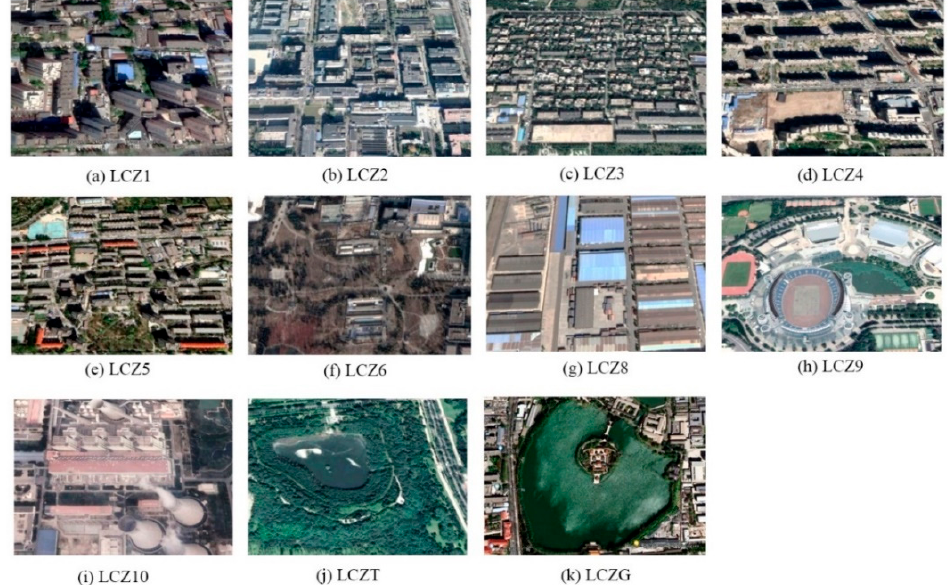
Figure 4. Samples of the LCZ from Google Earth: ( a ) LCZ1: compact high-rise; ( b ) LCZ2: compact midrise; ( c ) LCZ3: compact low-rise; ( d ) LCZ4: open high-rise; ( e ) LCZ5: open midrise; ( f ) LCZ6: open low-rise; ( g ) LCZ8: large low-rise; ( h ) LCZ9: sparsely built; ( i ) LCZ10: heavy industry; ( j ) LCZT: vegetation; ( k ) LCZG: water.